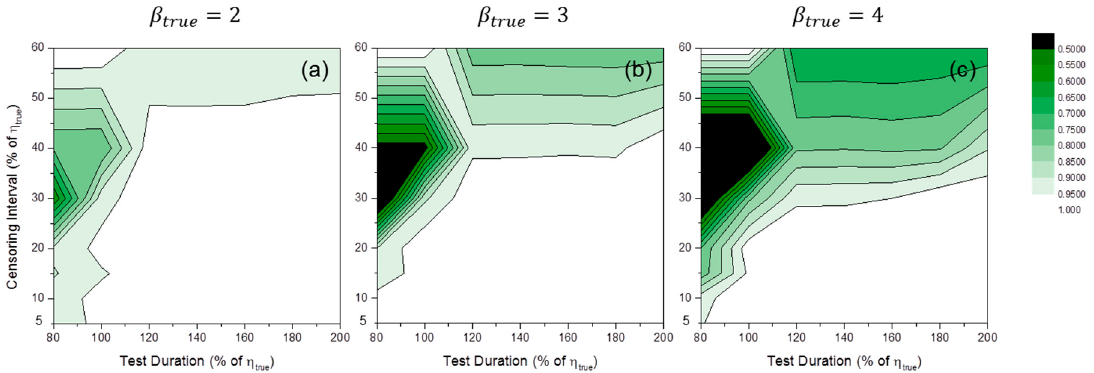
Figure 16. Convergence ratio distributions of MLE numerical estimation at: ( a ) (cid:2010) (cid:3047)(cid:3045)(cid:3048)(cid:3032) = 2 ; ( b ) (cid:2010) (cid:3047)(cid:3045)(cid:3048)(cid:3032) = 3 ; and ( c ) (cid:2010) (cid:3047)(cid:3045)(cid:3048)(cid:3032) = 4 (number of specimens: 10).